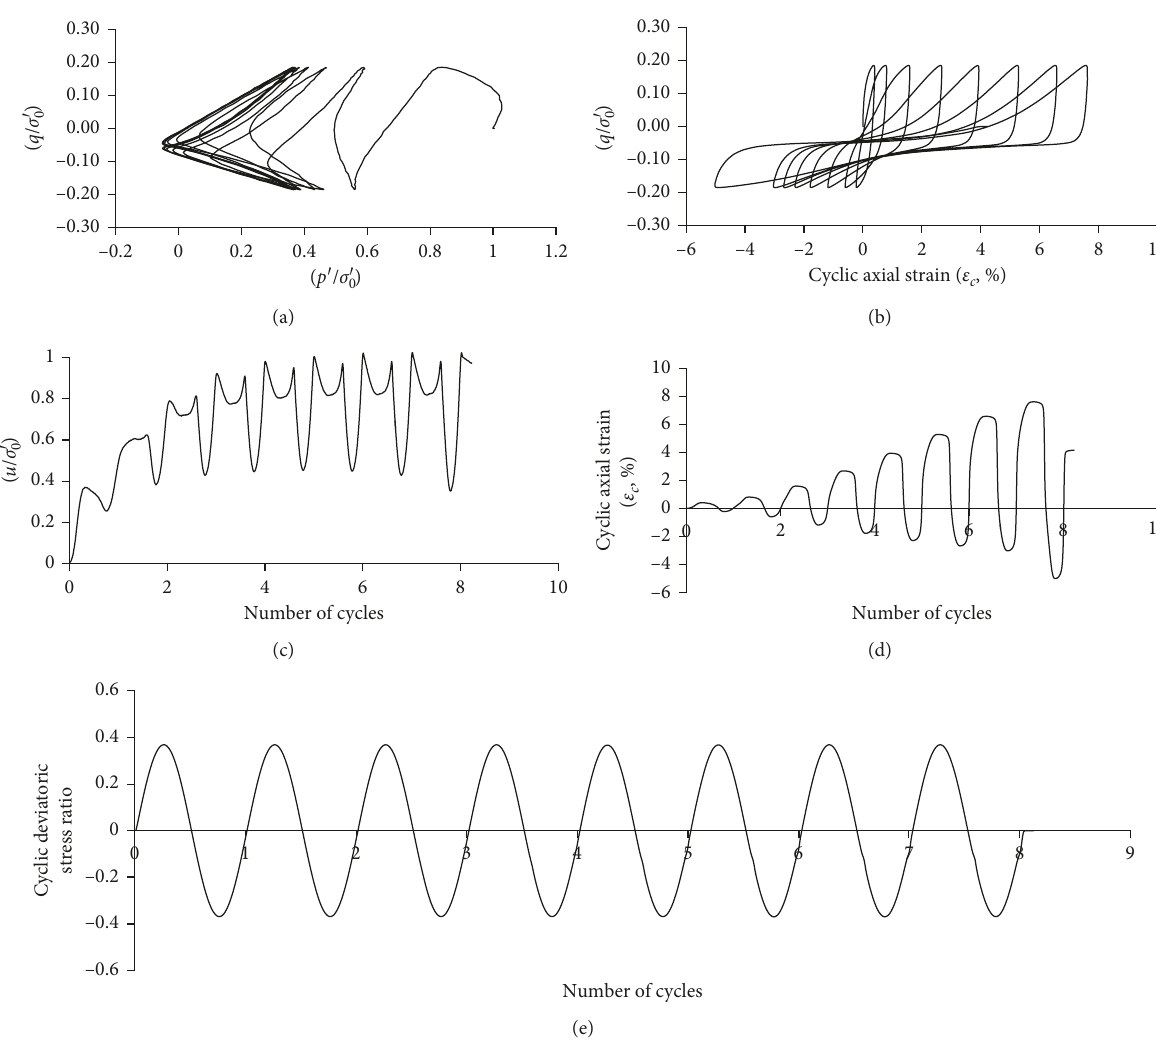
Figure 3: (a) Development of stress path. (b) Variation of stress path with cyclic axial strain. (c) Pore water pressure ratio with the number of cycles. (d) Cyclic axial strain with the number of cycles for a specimen of fiber-reinforced sand. (e) Cyclic deviatoric stress ratio with the number of cycles for a specimen of fiber-reinforced sand ( D r